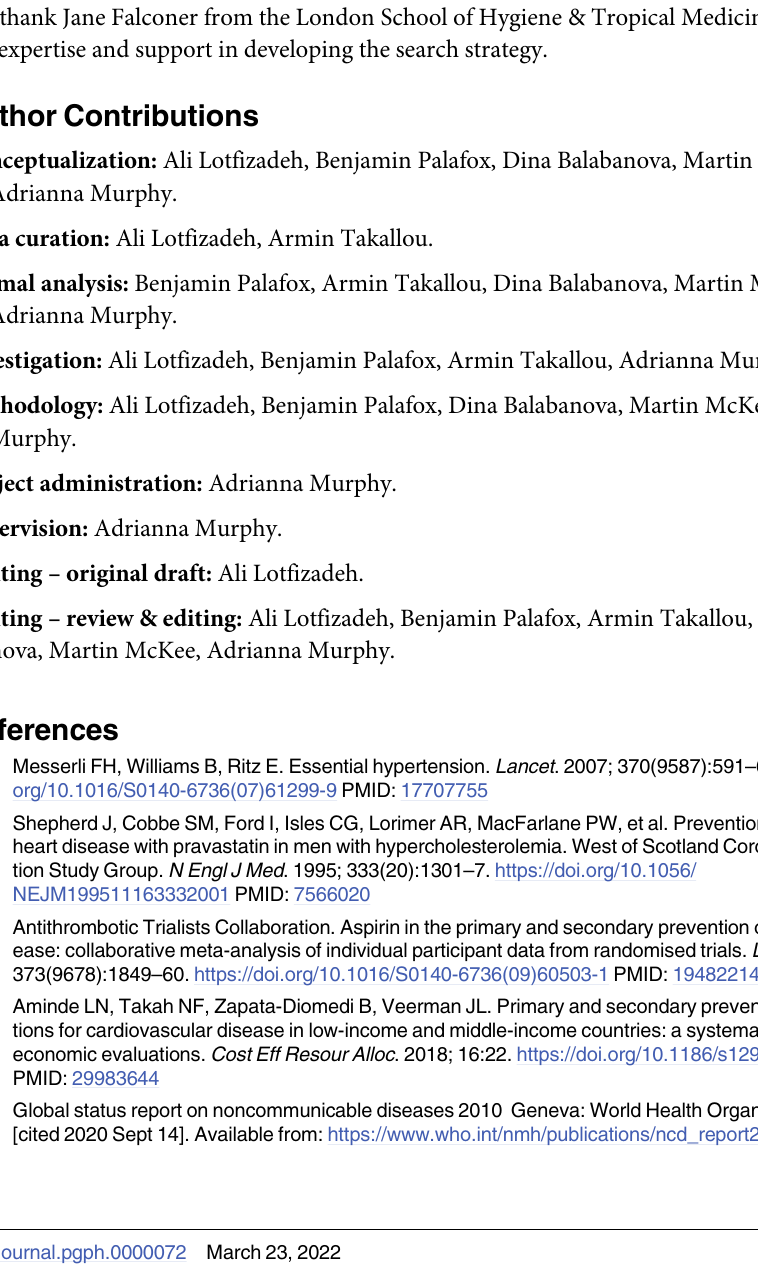
S1 Table. Complete search terms and search strategy for Medline search. S2 Table. Risk of bias tool for observational studies. S3 Table. Data extraction